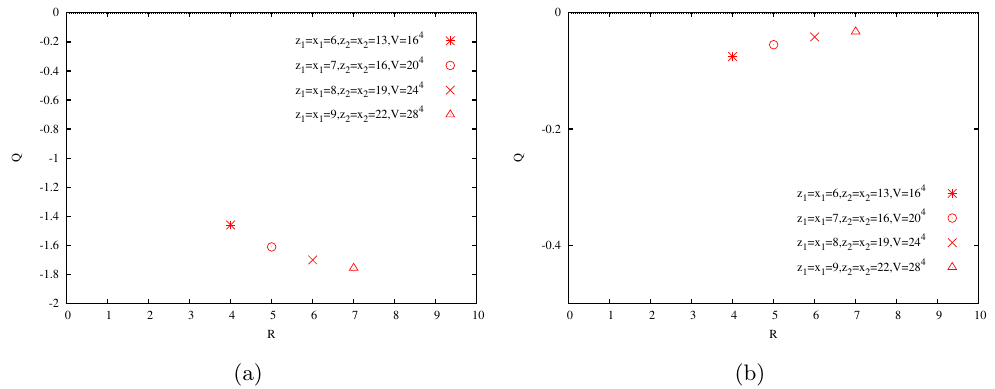
Figure 2 . (a) The total topological charge of the vortex con(cid:12)gurations corresponding to (cid:12)gure 3(a) and 3(b). In the left (right) diagram the colorful region in the xy-plane is centered at x 0 = x 1 ( x 0 = x 2 ) and y 0 = y ? . Increasing the radius R of the colorful region and increasing the lattice size the total topological charge converges to Q = (cid:0) 2 for the con(cid:12)guration of (cid:12)gure 3(a) and to Q = 0 for (cid:12)gure